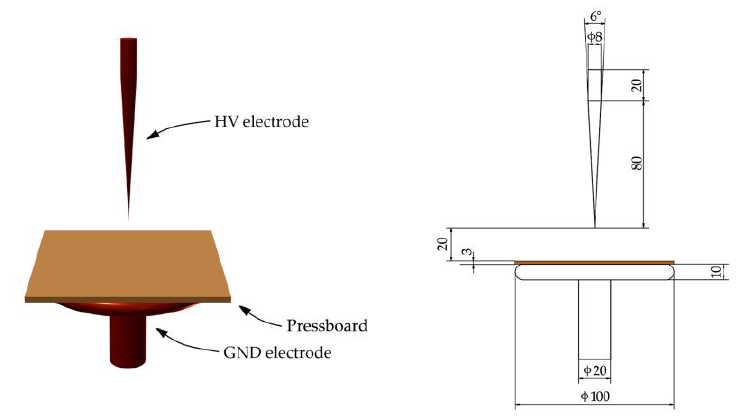
Figure 9. The applied electrode system for the generation of PD in oil.